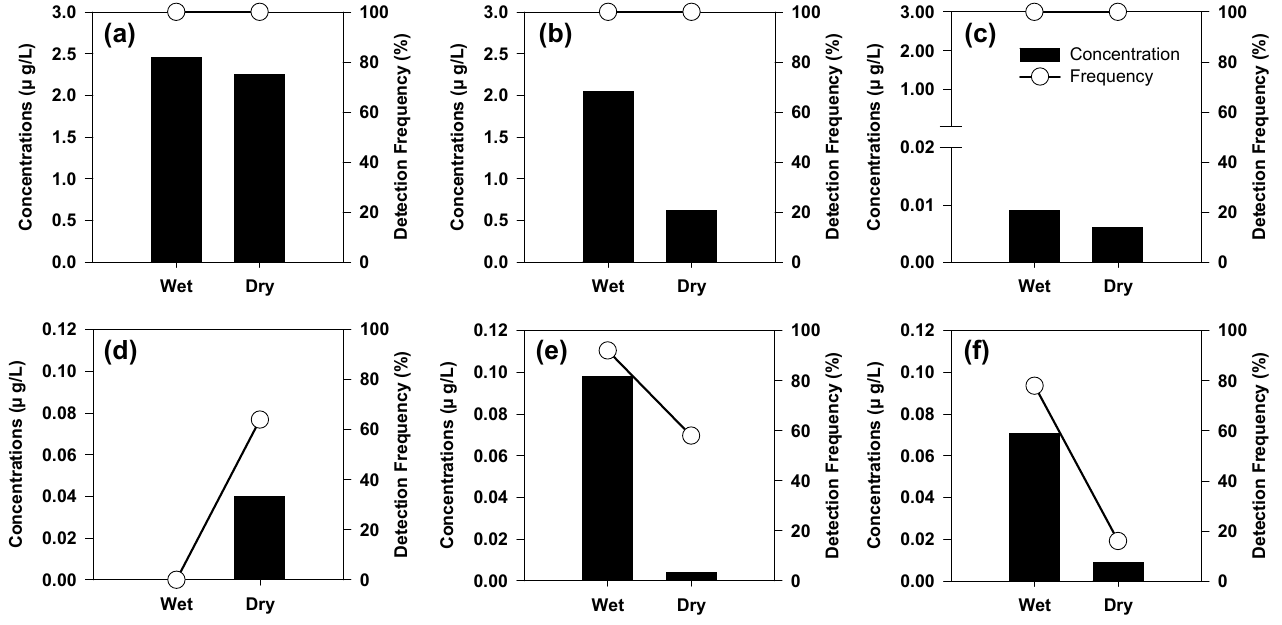
Figure 4. Wet and dry season variation of target compounds ( a ) Cr, ( b ) As, ( c ) Hg, ( d ) quinoline, ( e ) carbofuran, ( f ) bisphenol-A in the Han River watershed.